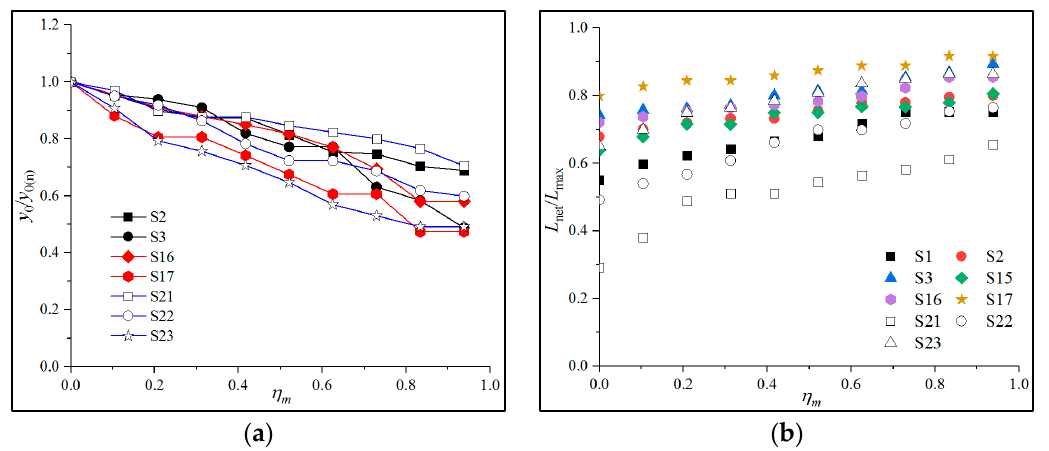
Figure 5. The backwater depth and L net at different atmospheric pressures. ( a ) the change in backwater depth with η m ; ( b ) the relation between L net / L max and η m .